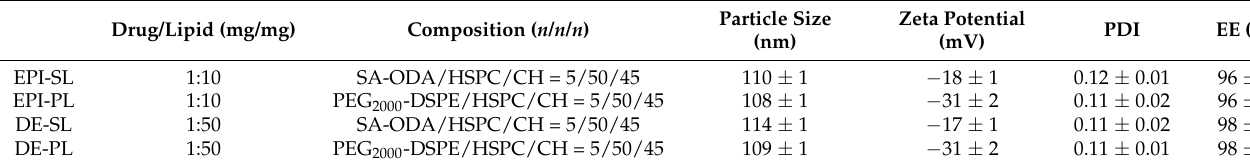
Table 1. Basic parameters of the liposomes ( n =